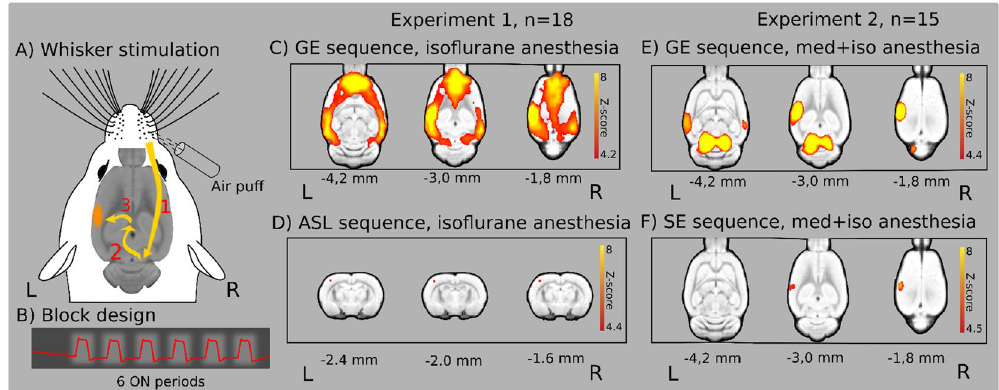
Figure 1. Air-puff stimulation of the right whisker pad in experiment 1 and 2 after saline pretreatment (n = 18 and n = 15 rats, respectively). ( A ) Signal path from whisker stimulation to activation in the barrel cortex [(1) trigeminal nerve, brain stem, (2) sensory information to the thalamus, (3) the primary somatosensory barrel cortex (BC)]. ( B ) Block-design of whisker air-puff stimulation. ( C ) Widespread cortical BOLD activation in isoflurane anesthesia with gradient-echo (GE) EPI sequence. ( D ) Limited activation detected in the BC with the ASL sequence in the same experiment. ( E ) Pronounced activation in the left BC and bilaterally in the IC in the combined anesthesia. ( F ) Limited activation in the BC with the SE sequence in the same experiment. The Z-scores represent voxelwise statistical inference (p < 0.05 correcting for multiple comparisons via GRF theory based FWER). The corresponding colorbars are depicted on the right. The z (or y) coordinates (distance from Bregma) are given below the slices (L and R stand for